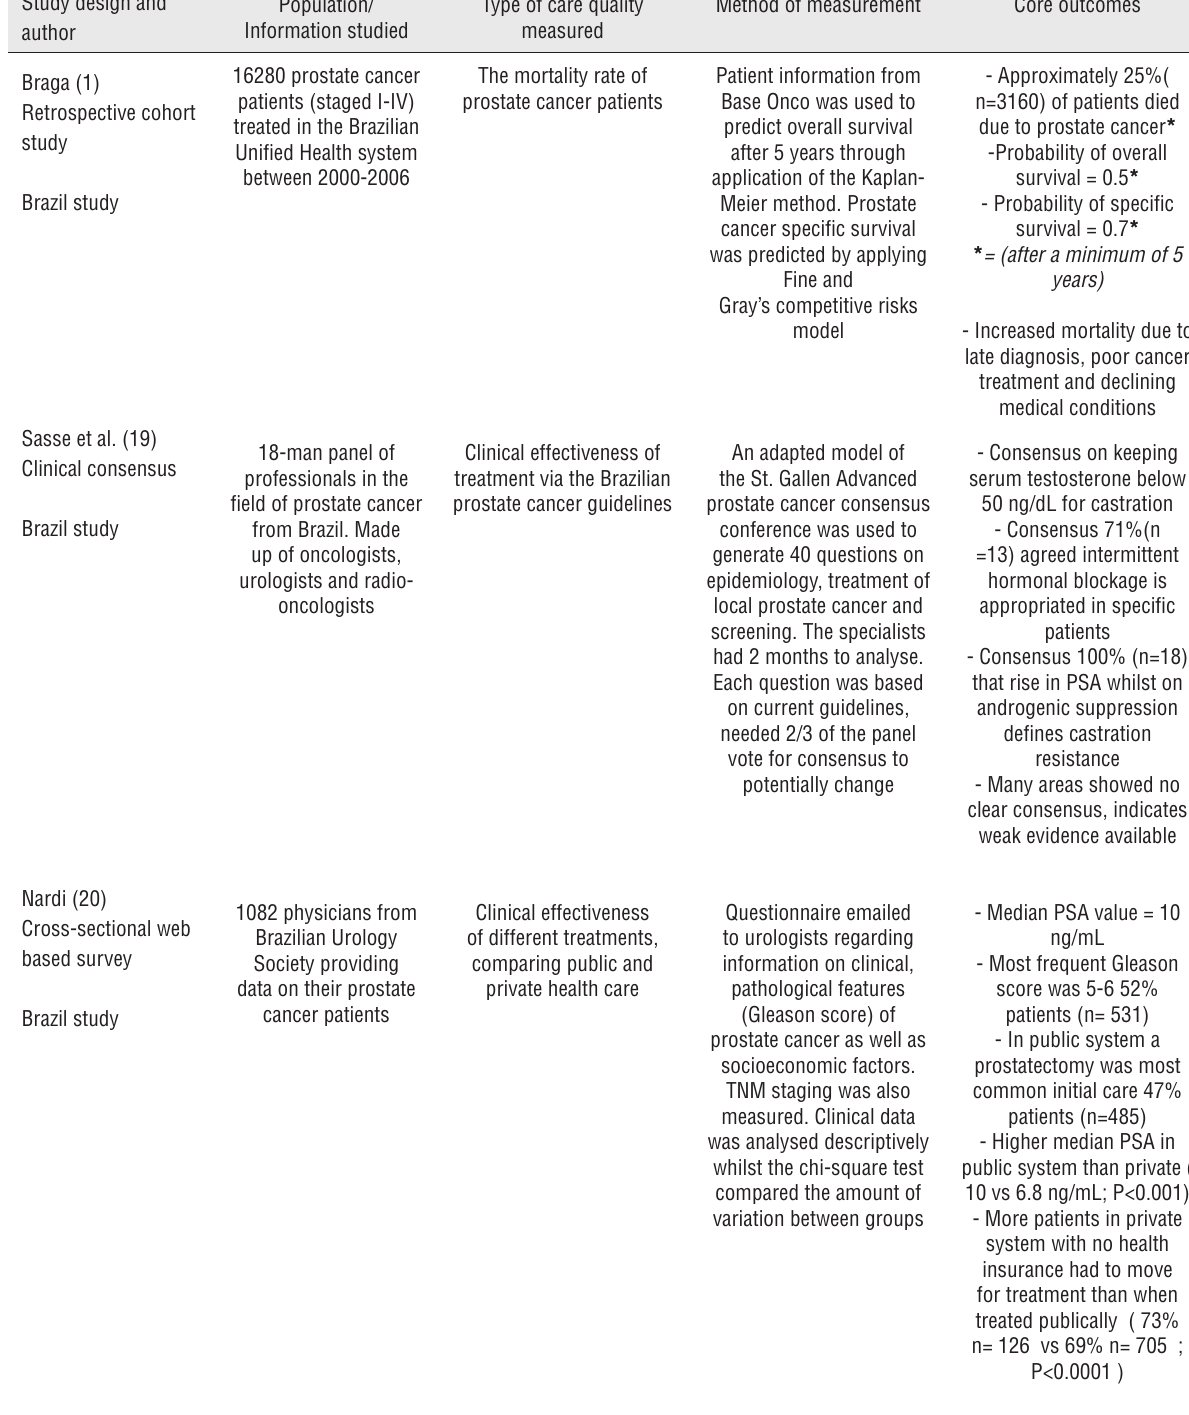
Table 6 – Summary of selected studies measuring prostate cancer care in Brazil and the